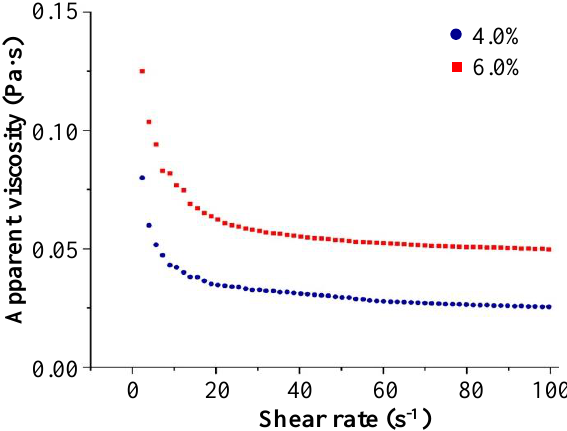
Figure 5. Dependence of apparent viscosity on the shear rate of OPP-D.